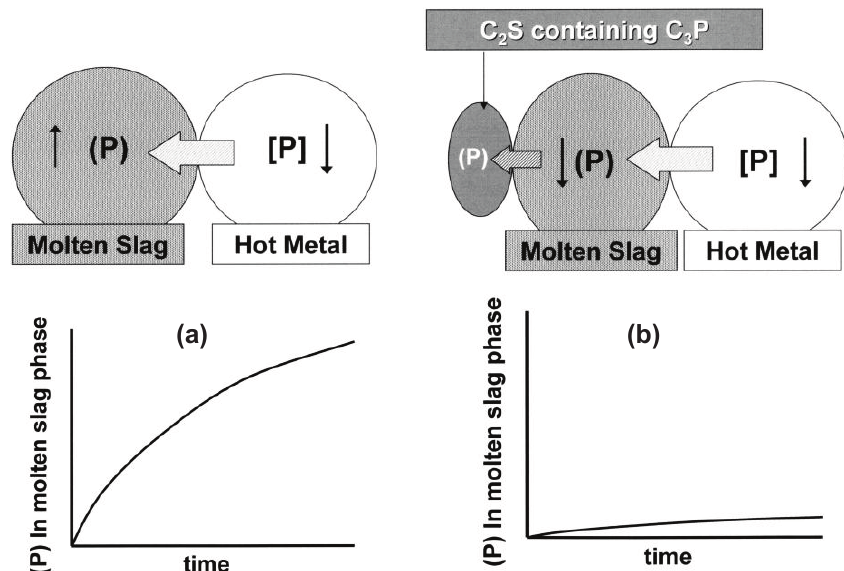
Figure 2. Process image to use multi-phase slag for dephosphorization